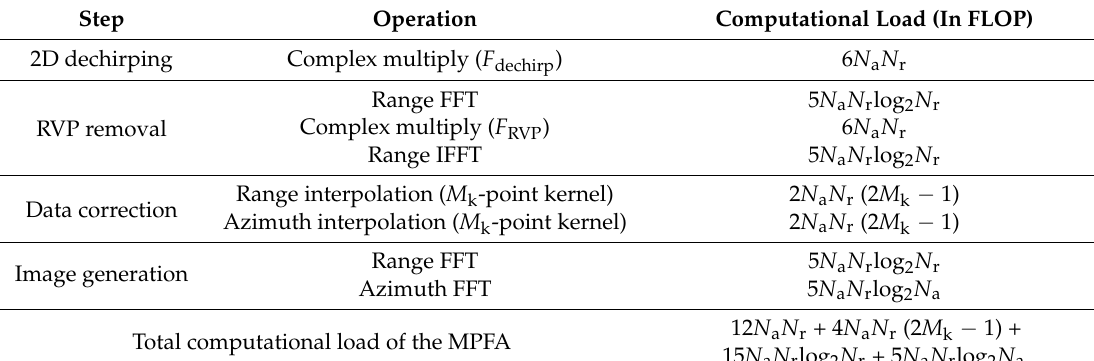
Table 2. Computational load of the Modified Polar Format Algorithm